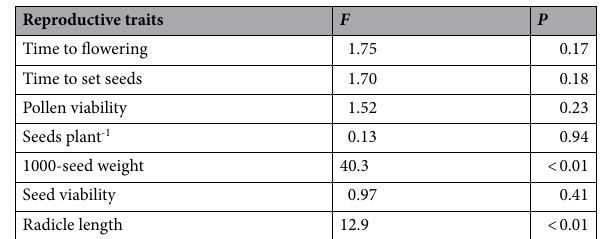
Table 1. F statistics and P values for the effect of EPSPS gene copy number on reproductive traits of Bassia scoparia plants in the absence of glyphosate in the field averaged over 2 years at the Montana State University Southern Agricultural Research Center near Huntley, MT,